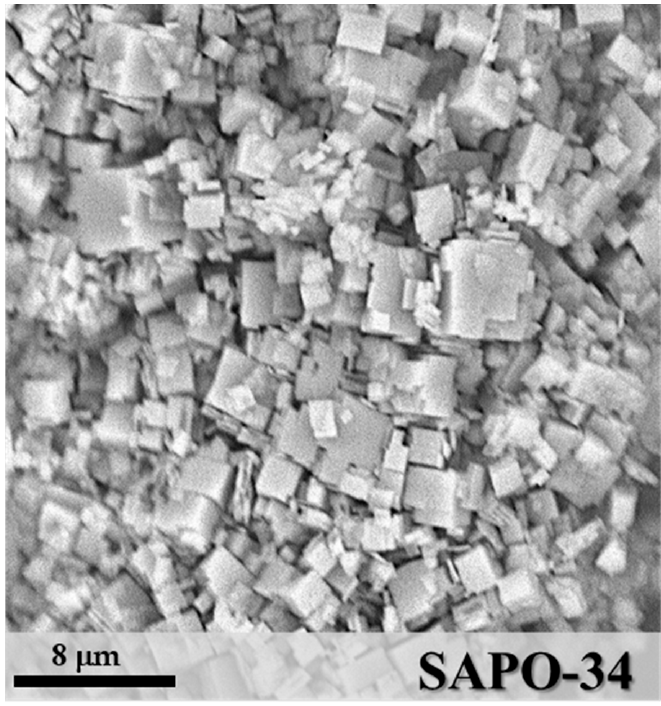
Figure 3. SEM image of the synthesized SAPO-34.